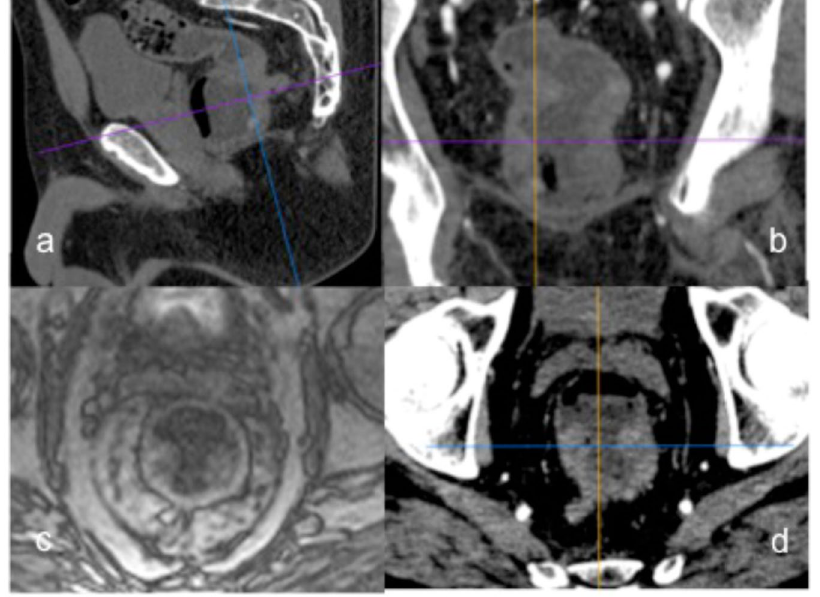
Figure 2. Example of corresponding rectal cancer tumour areas in MR and CT and localization of the investigated tumour area within the pelvis: ( a ) Sagittal view of the rectal carcinoma and localization of the the representative tumour area investigated with perfusion analysis. ( b ) Coronal view of the rectal carcinoma and localization of the representative tumour area investigated with perfusion analysis. ( c ) Paraaxial MR image from the T1 weighted TWIST angiographic stack perpendicular to the rectum lumen, with representative semicircular tumour area at 3 to 9 o’clock suitable for tumour perfusion analysis. ( d ) Paraaxial CT image from the dVPCT stack perpendicular to the rectum lumen, with the corresponding representative semicircular tumour area at 3 to 9 o’clock suitable for tumour perfusion analysis.